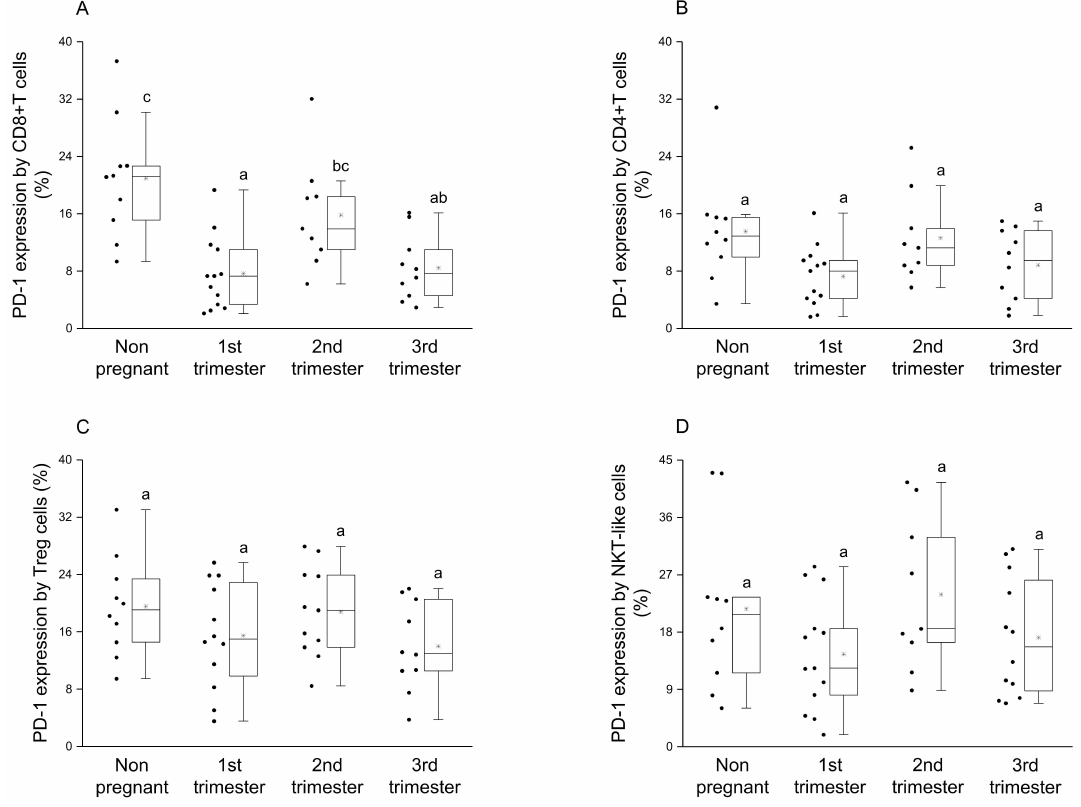
Figure 1. PD-1 receptor expression by di ff erent T cell throughout pregnancy and in nonpregnant women. The expression of PD-1 molecule by CD8 + T cell ( A ), CD4 + T ( B ), Regulatory T (Treg) ( C ) and NKT-like ( D ) subpopulations. The solid bars represent medians of 10, 13, 10 and 12 samples, the boxes indicate the interquartile ranges and the lines show the most extreme observations. Di ff erences were considered statistically significant for p -values ≤ 0.05. Variables with the same letter indicate no statistically significant di ff erence, while di ff erent letters indicate a statistically significant di ff